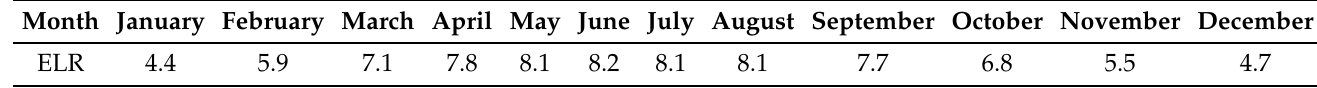
Table 2. Air temperature ELR ( ◦ C · km − 1 ) variations for each month of the year in the Northern Hemisphere